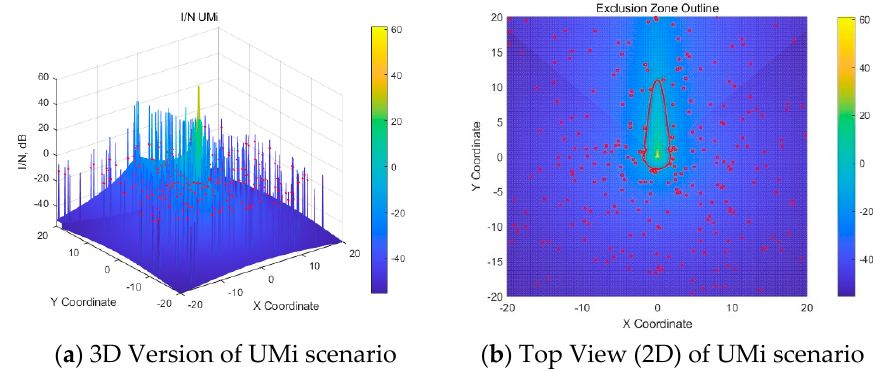
Figure 12. UMi scenario with ES antenna elevation angle of 5°.